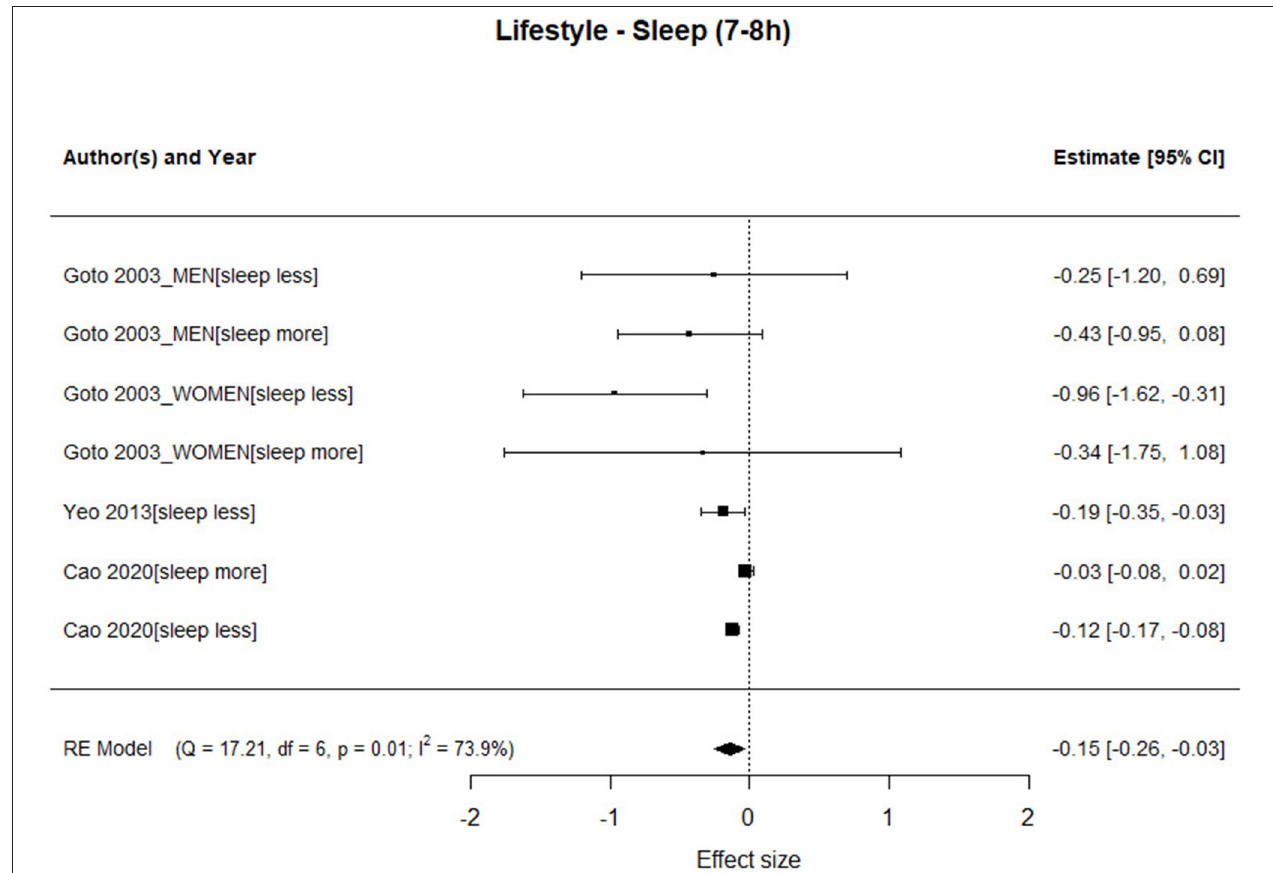
FIGURE 5 | Association between hours of sleep and risk of